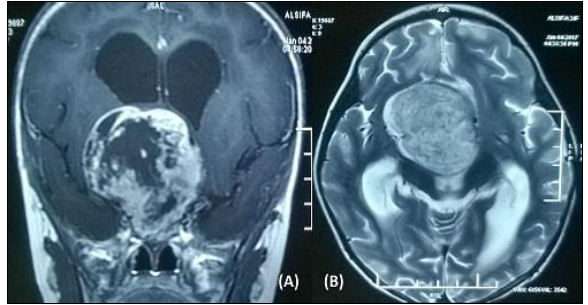
Figure 2: figures, contrast T1-weighted (A) and T2-weighted (B) magnetic resonance images of 2 months old child showing a heter- ogeneously enhancing solid-cystic mass extending from suprachi- Figure 4: Non-contrast (A) and contrast enhanced (B)T1-weighted asmtic region to third ventricle. Histopathological diagnosis was magnetic resonance images of a patient showing solid-cystic mass pilocytic astrocytoma. with heterogeneous contrast enhancement and intensity sugges- tive of